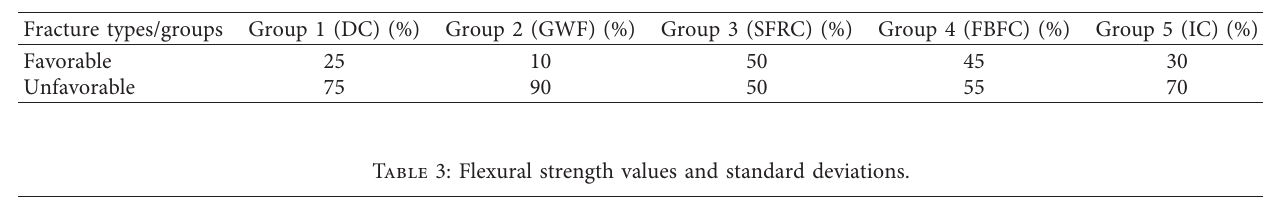
Table 2: Distribution of favorable and unfavorable fractures by groups.